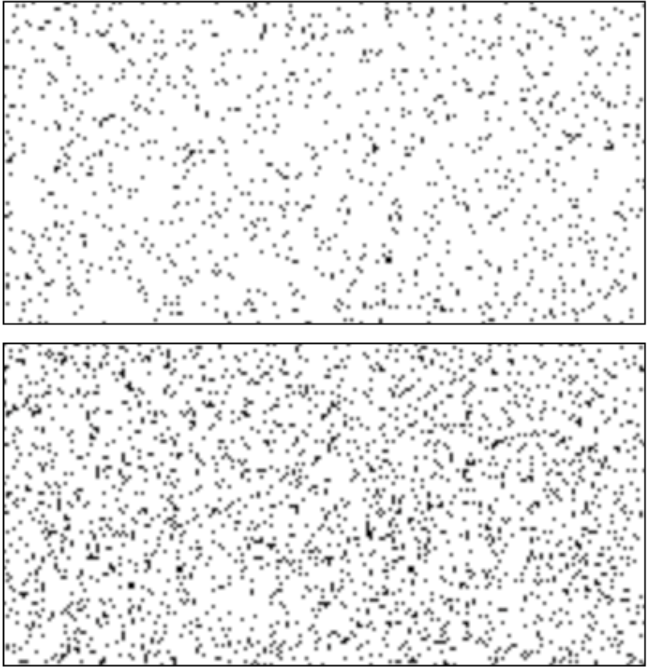
Figure 1. Example items from the SUD task. The box on the top is the least dense item, and the box on the bottom is the densest.